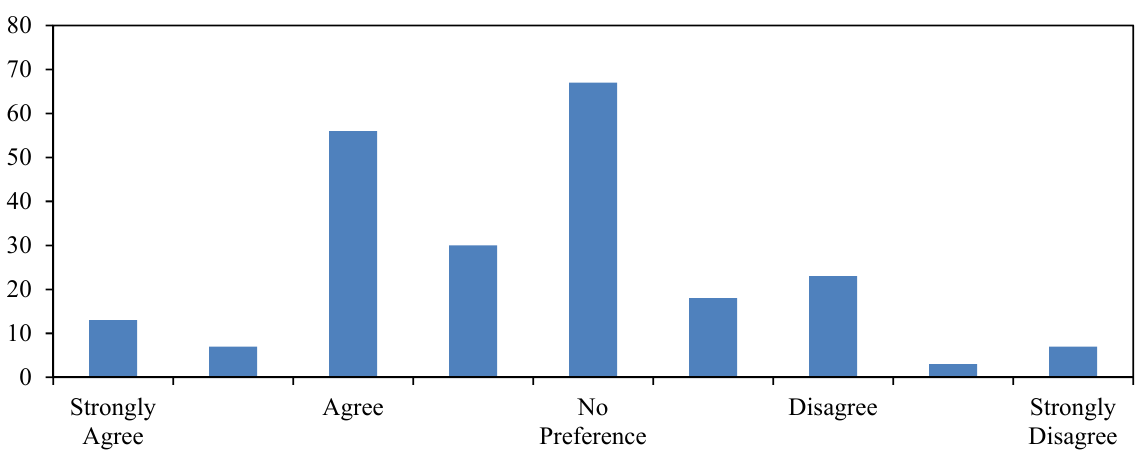
Figure 15. Graph of responses to the statement “As an editor for a journal, I would publish an article with computer-generated